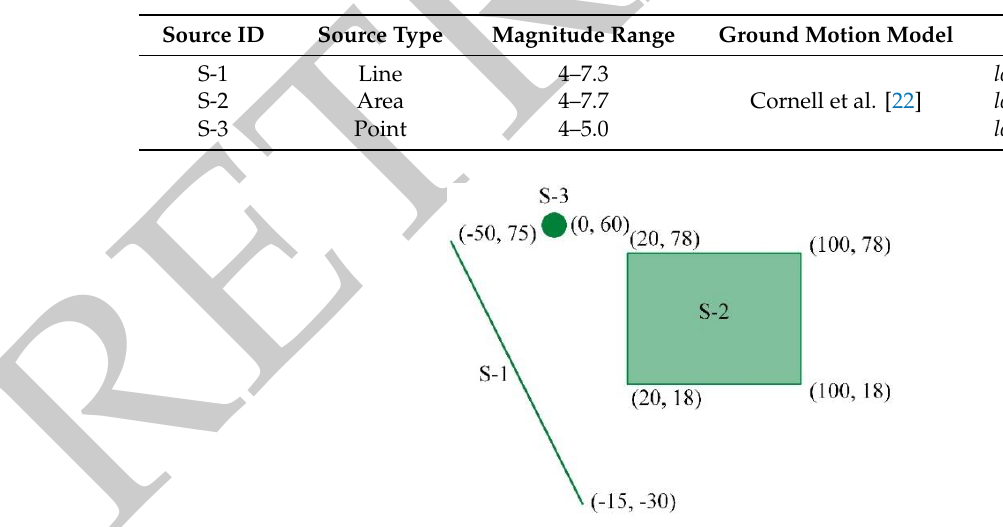
Table 2. Source information of the example.